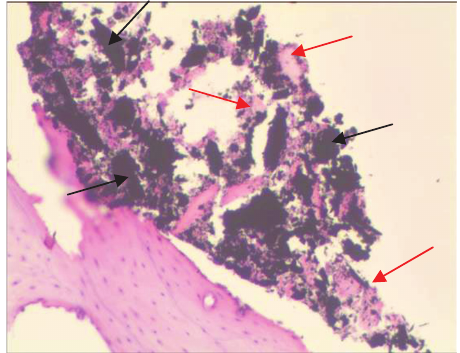
Figure 8 Micrograph of the HA coating interface 150 days after implantation under hematoxylin and eosin staining (black and arrows represent the C/C composite and red bone trabeculae, respectively).